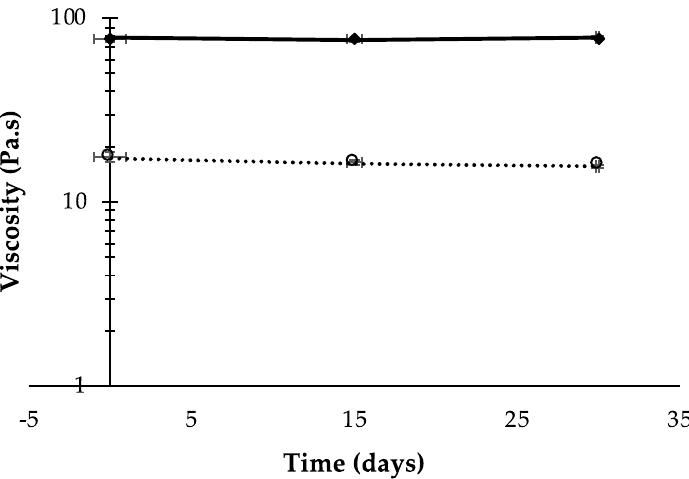
Figure 4. Graphic representing the variation of viscosity (Pa.s) vs. time of the formulation with C. sativa shells extract at a shear rate of 1.070 s − 1 (upper line) and a shear rate of 10.060 s − 1 (lower line) (mean ± standard deviation, n = 3).